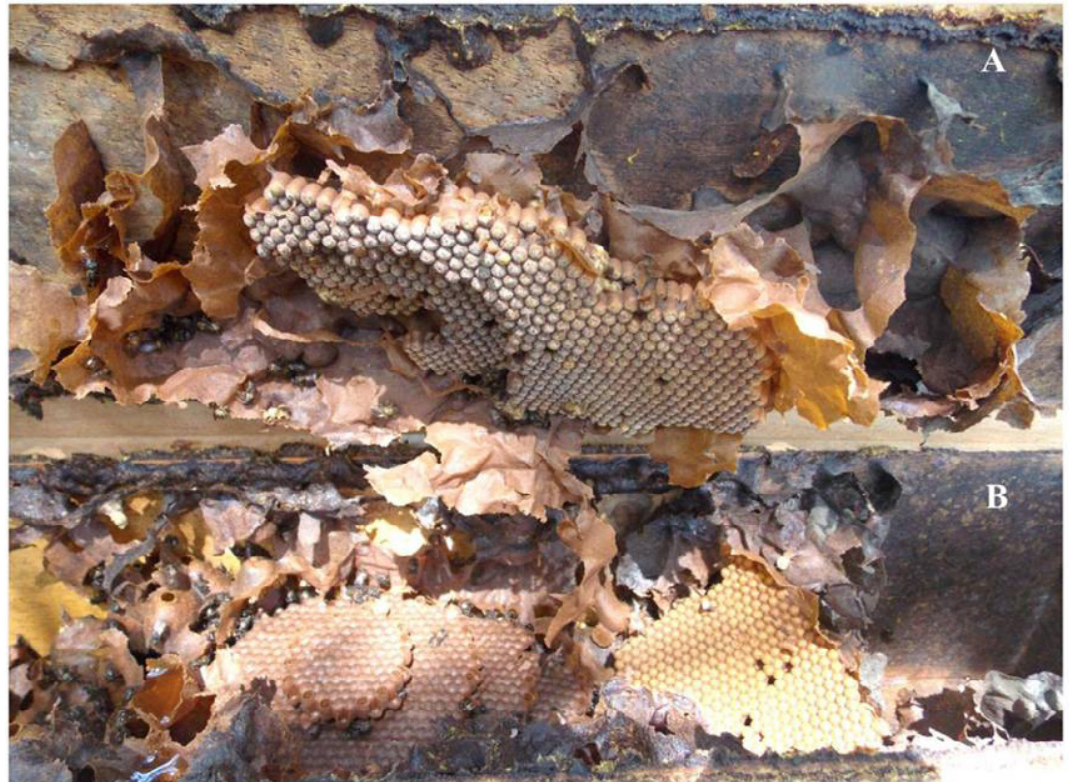
Fig 4 . Brood combs of Scaptotrigona aff. postica stuck to the lid of the horizontal hive, hindering management. A-cover; B-Base